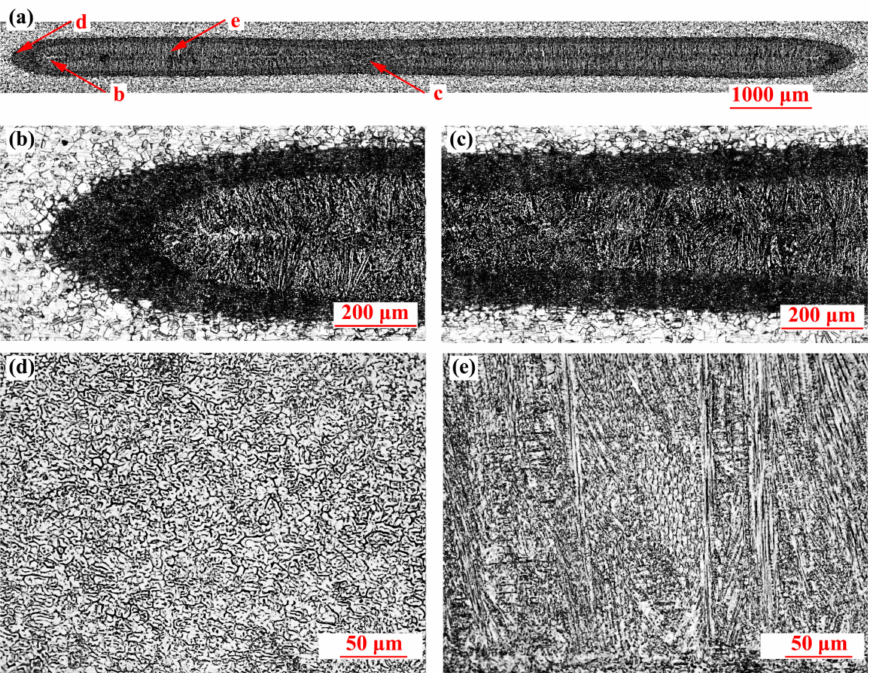
Figure 8. Metallographic morphology of nugget on the transverse cutting section (The welding current is 15 kA): ( a ) overall perspective; ( b ) morphology on the nugget left side; ( c ) morphology on the nugget middle side; ( d ) morphology on the equiaxed zone and ( e ) morphology on the columnar crystal zone.